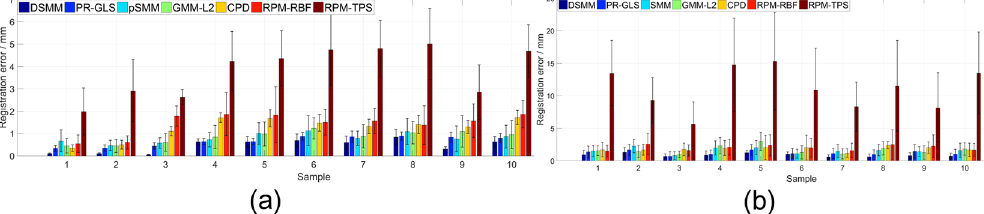
Figure 9. Quantitative evaluations of non-rigid point set registration algorithms on twenty 3D lung point sets, in which 10 samples are extracted from 4D CT and the other 10 samples are extracted from COPD. Mean 3D Euclidean magnitude distance between correspondences is used as a statistical measure for quantitative evaluations. The mean distance of each sample before registration is demonstrated in Table 3. ( a ) Performance of the non-rigid point set registration algorithms on 3D point sets extracted from thoracic 4D CT images. ( b ) Performance of each algorithm on the dataset extracted from COPD images. DSMM outperforms other competing algorithms both on the datasets from thoracic 4D CT images and COPD images.